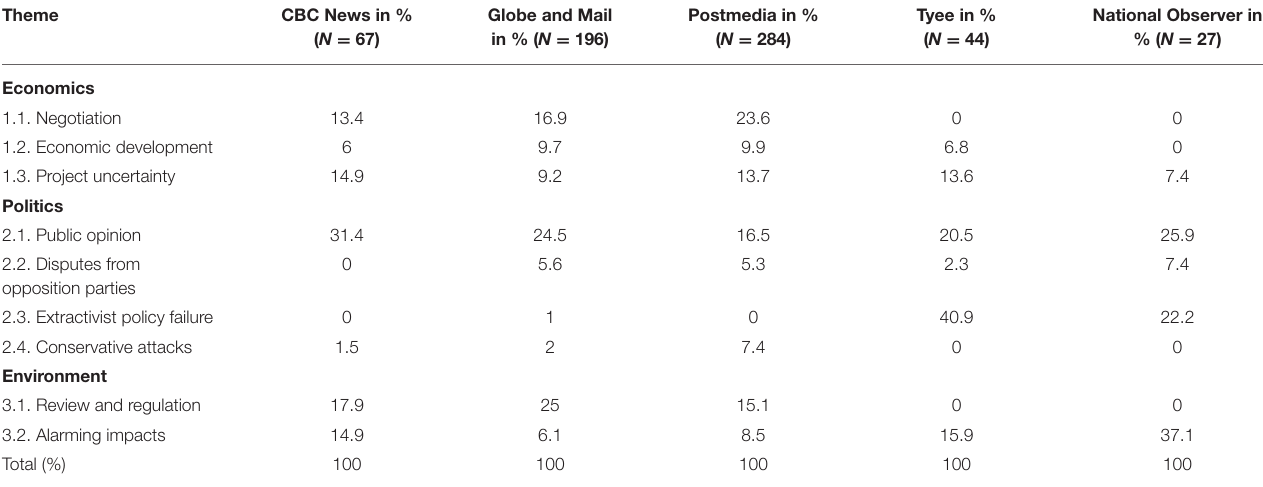
TABLE 7 | Thematic distribution of news items.